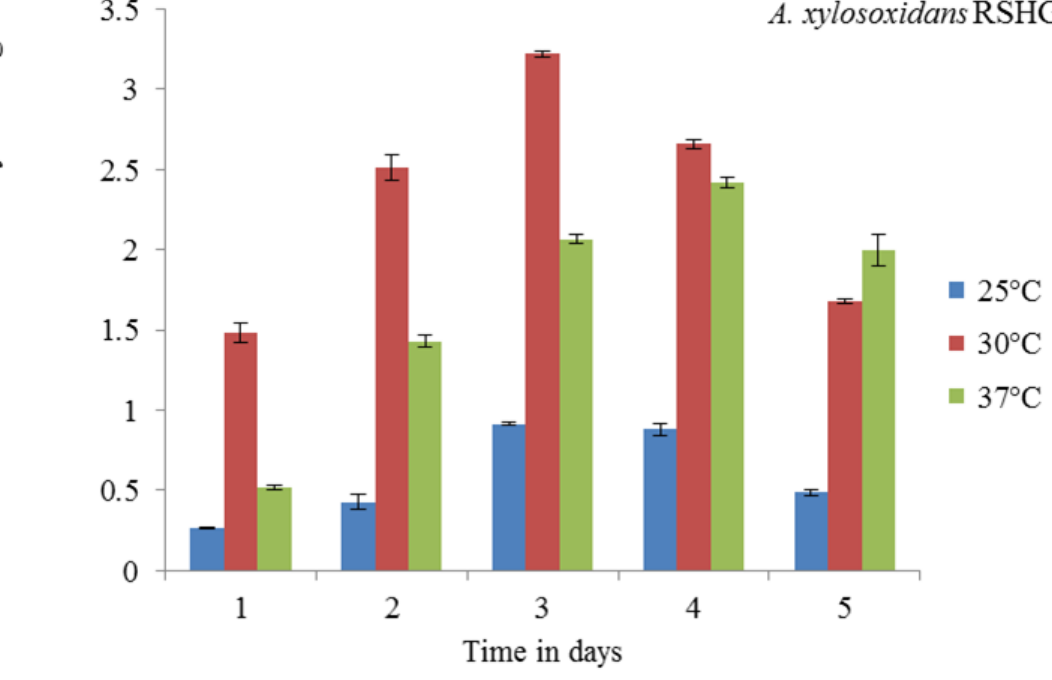
Figure 5. Effect of temperature on Glutaminase production by A. xylosoxidans RSHG1, pH 9.